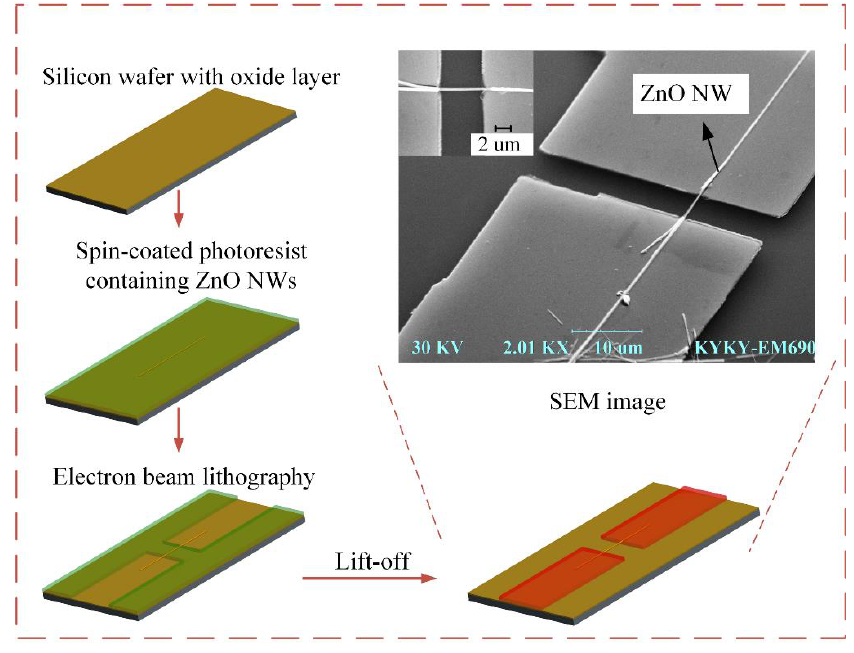
Figure 1. Fabrication process of ZnO NW resonator.